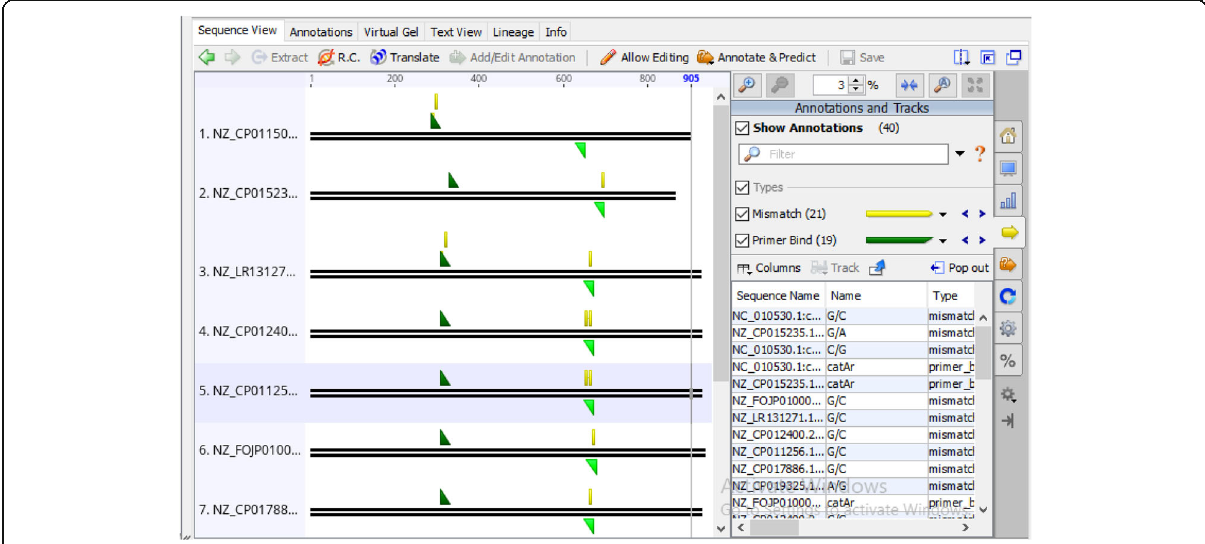
Fig. 11 In silico PCR result showing amplification of catechol 1,2-dioxygenase (C12O) gene fragments in authentic bacterial strains